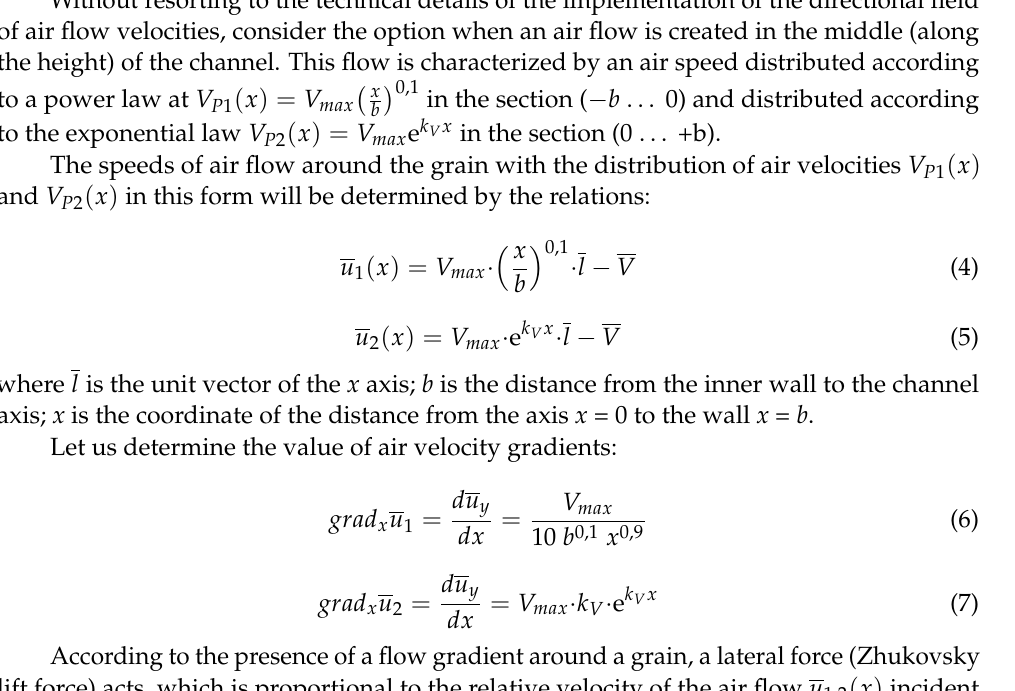
Figure 4. Scheme of a pneumatic gravitational separator ( a ) with options for supplying external air and a design scheme ( b ) for the force interaction of grains with an air flow: 1—air flow supply in the zone of grain material components coming off from the cone; 2—air flow supply in the zone of separation of grain material components according to their density; 3—air flow supply in the output zone of grain material fractions; I—output of the grain material fraction with the highest density (1350–1500 kg m −3 ); II—output of the fraction of grain material with an medium density (1200–1350 kg m −3 ); ІІІ—output of light fraction of grain material with density 500–1200 kg m −3 .